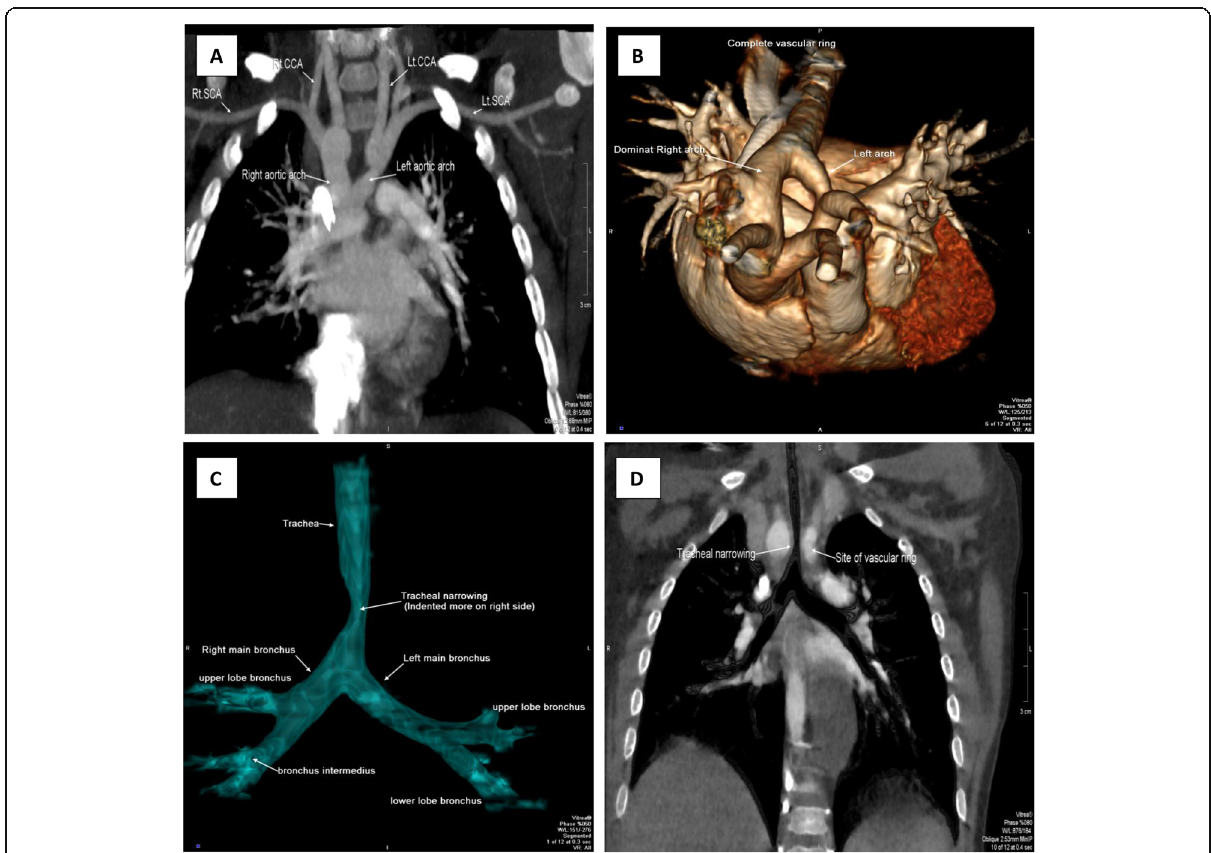
Fig. 5 A case of double aortic arch aged 9 months presented with dyspnea. a 2D MIP coronal image showing complete vascular ring formation by two aortic arches with the previously described branching pattern. b Volume rendered superior view of the heart and great vessels showing double aortic arches with right side predominance forming a complete vascular ring. c , d Tracheal narrowing at site of vascular ring shown in volume rendered image of the trachea ( c ) and in coronal MinIP image ( d